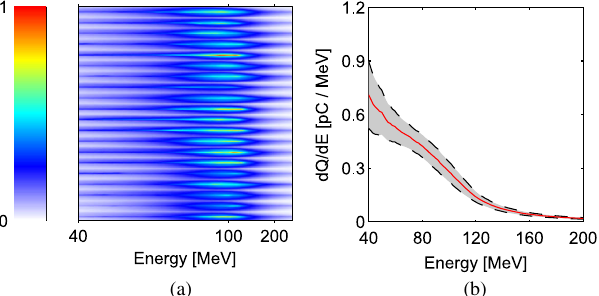
FIG. 3. False color images of the dispersed electrons on the scintillating screen from 15 consecutive shots are shown in (a), all using the same color scale. The average electron spectrum of all shots in the sequence is plotted as a solid red line in (b). The shaded area, bounded by dashed lines, shows the corresponding standard deviation from the average spectrum. Over the full energy range, the maximum standard deviation from the average spectrum is 27%.